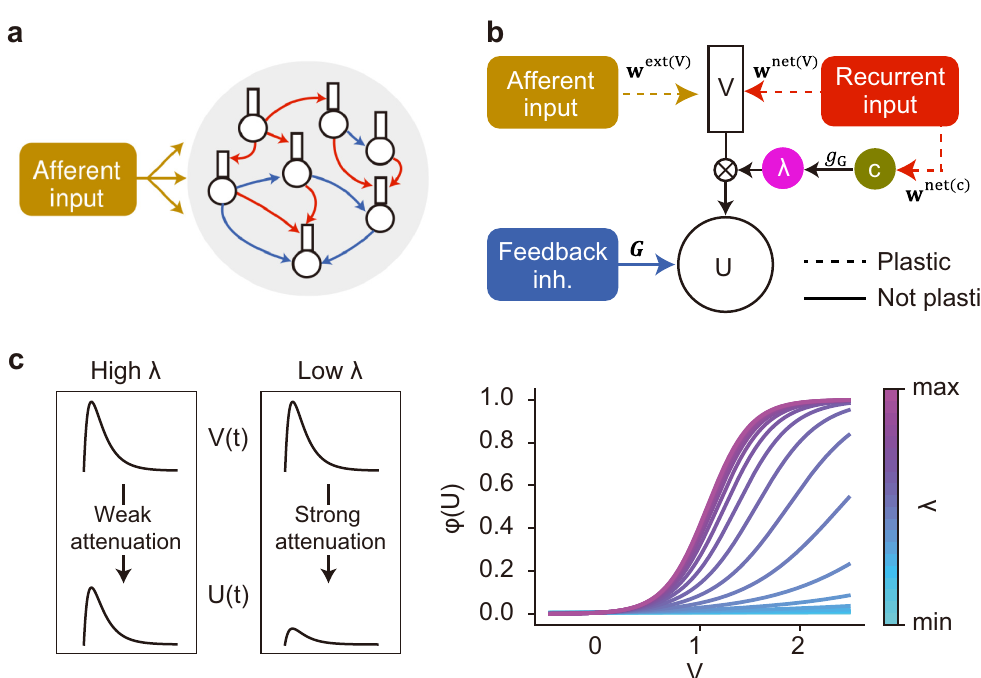
Fig 1. A recurrent gated network of compartmentalized neurons. (a) A network of randomly connected compartmentalized neurons is considered. The red and blue arrows indicate recurrent connections to the dendrite, and the feedback inhibition to the soma, respectively. (b) Each neuron model consists of a somatic compartment and a dendritic compartment. Dashed and solid arrows indicate plastic and non-plastic synaptic connections, respectively. Unless otherwise specified, the dendrite only receives afferent inputs. The somatic compartment integrates the dendritic activity and inhibition from other neurons. Gating factor λ is determined by recurrent inputs and regulates the instantaneous fraction of dendritic activity propagated to the soma. (c) The effect of gating factor on the somatic response is schematically illustrated (left). The relationship between the dendritic potential and somatic firing rate is shown for various values of gating factor